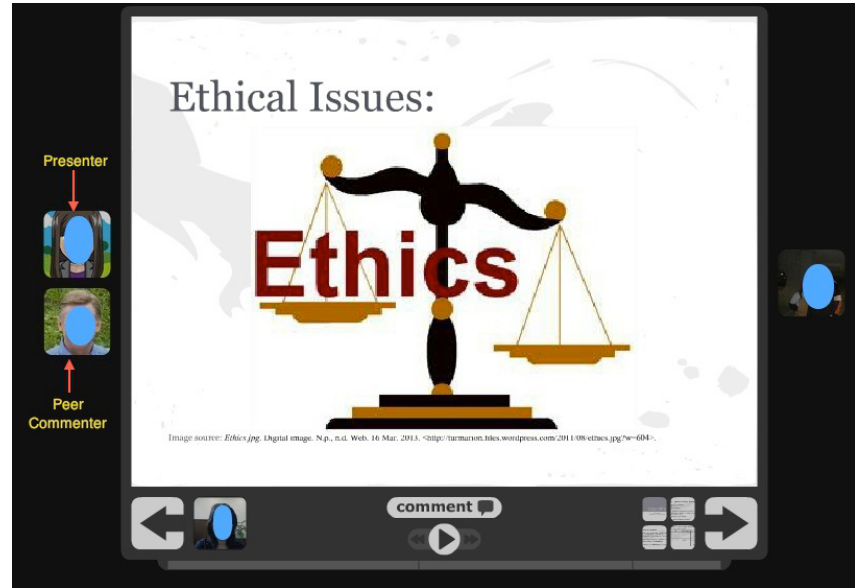
Figure 1 . An example of role-playing peer feedback activity on